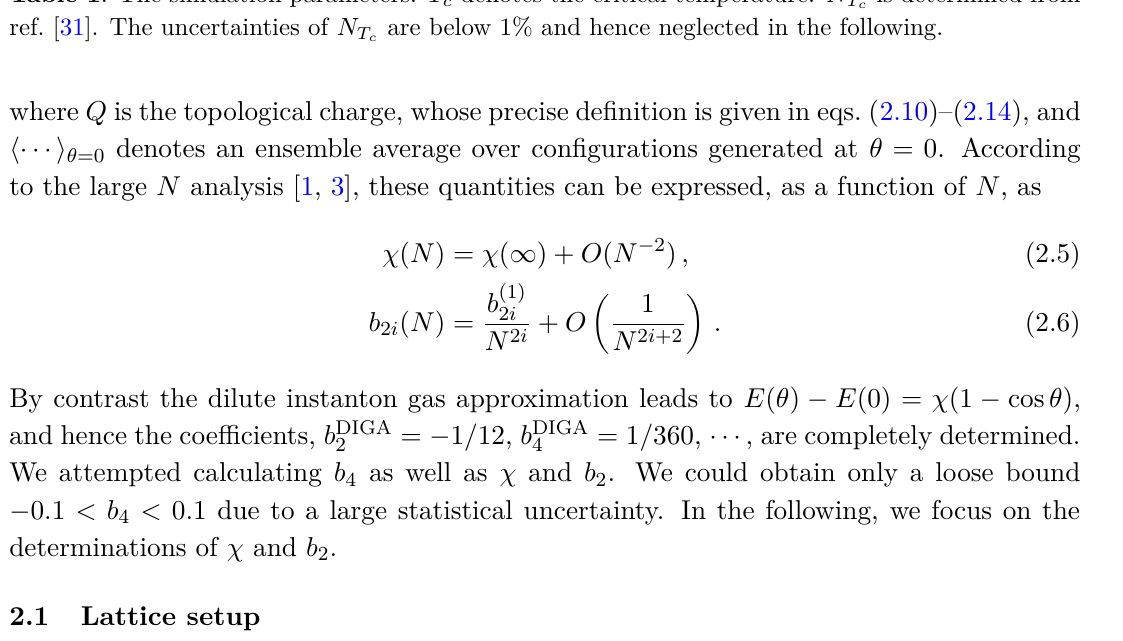
are below 1% and hence neglected in the T c